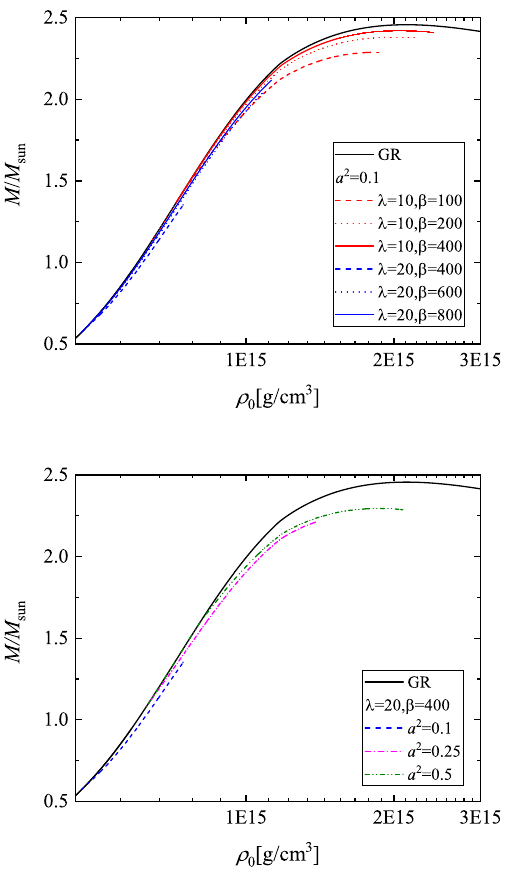
Fig. 1 Mass of radius relation for models with different values of the parameters. Top Fixed value of a 2 and different values of λ and β . Bottom Fixed values of λ and β and different values of a 2 . The mass